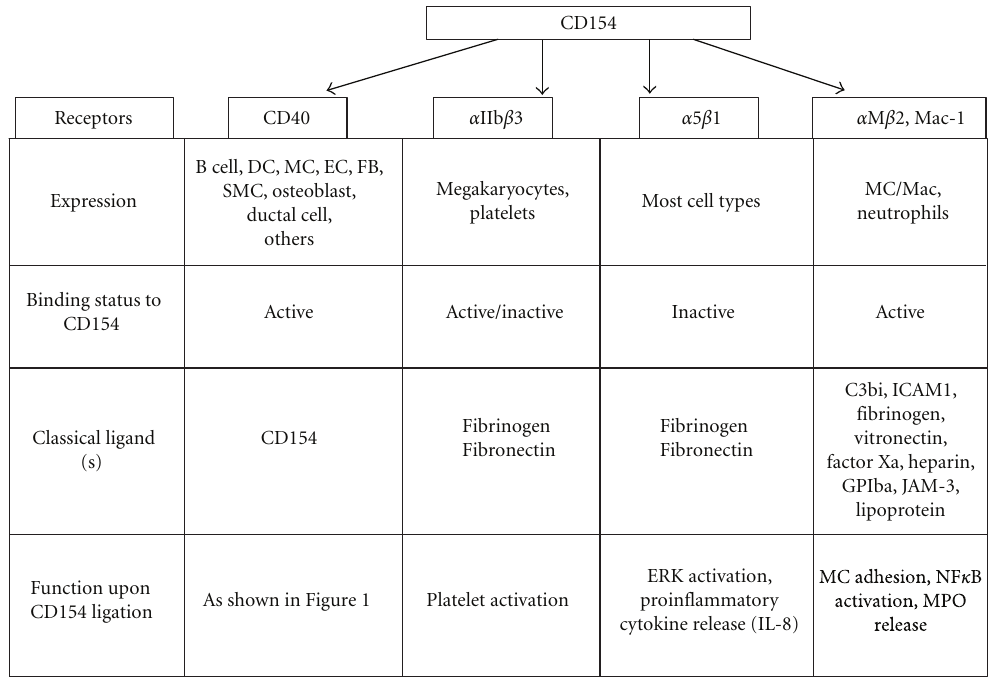
Figure 2: Structural and functional characteristics of CD154 receptors. Four receptors for CD154 have been identified, namely, CD40, α IIb β 3, α 5 β 1, and α M β 2. These receptors are found on various cell types and induce di ff erent biological functions upon CD154 binding. APC: antigen presenting cells, DC: dendritic cells, MC: monocyte, EC: endothelial cell, FB: fibroblast, SMC: smooth muscle cell, Mac: macrophage, ICAM: intercellular adhesion molecule, GPIb α : glycoprotein Ib α , JAM-3: junctional adhesion molecule-3, MPO: myelo-